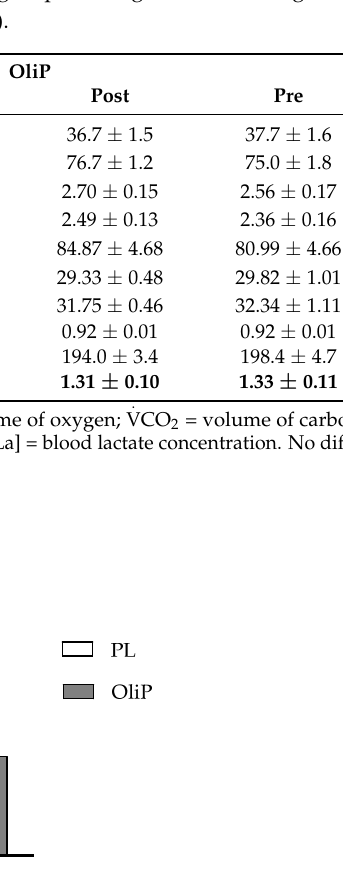
Figure 2. Time constant ( τ ) at the onset of exercise pre- and post-intervention for OliP and PL groups. * denotes significant difference between groups pre intervention ( p = 0.047), ** denotes significant difference between time points for OliP ( p = 0.005).Lactate threshold 1 (LT1): Respiratory parameters, exercise economy, B[La] and RPE are shown in Table 5A pre- to post-intervention for both OliP and PL. There was a significant interaction effect for relative V̇ O 2 (time x group: F = 4.66, p = 0.039, η p2 = 0.16, Figure 3A), where a reduction in relative V̇ O 2 was found in the OliP group between visit 3 and 5 (F = 7.09, p = 0.013, η p2 = 0.22). Whilst no differences were found post interven- tion between OliP and PL, when expressed as relative change, OliP demonstrated a − 2.7 ± 1.2% reduction in V̇ O 2 compared with the PL group at LT1 intensity ( − 0.7 ± 1.0%; t = 2.13, p = 0.043, d = 0.82, 95% confidence interval [CI] range 0.05 to 1.64). This corresponded with a significant reduction in the % of V̇ O 2max from baseline (73.7 ± 1.8% in visit 3 to 71.2 ±1.6% in visit 5) (F = 7.72, p = 0.01, η p2 = 0.24, Figure 3B) for OliP only. No differences were reported in the PL group ( p > 0.05), or post